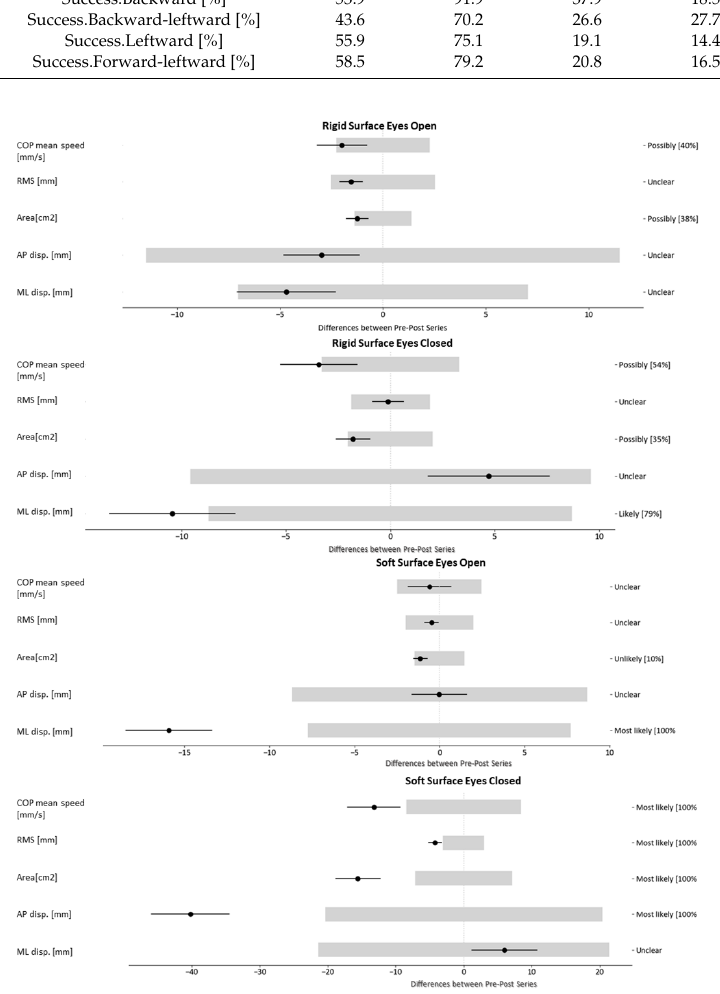
Figure 3. Patient level analysis. Limits of Stability. Minimal detectable change: light grey bars; Differences: Black thin bars.